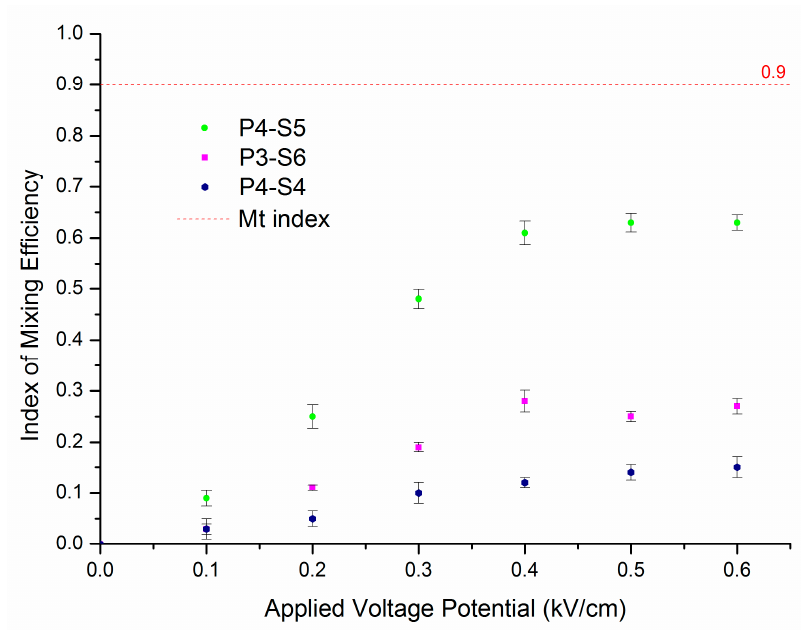
Figure 6. The index of the mixing efficiency with various commonly used potentials.